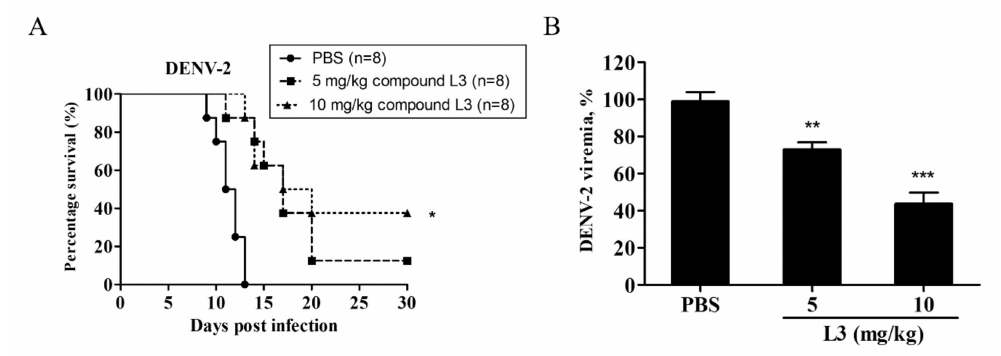
Figure 5. Compound L3 exhibited protective e ffi cacy in vivo. AG129 mice were infected with 10 7 focus-forming unit (FFU) of DENV-2 and treated orally with 5 or 10 mg / kg of compound L3 daily for 7 days. ( A ) Survival rates were determined for 30 days. The number of animals (n) in each group is shown. The data are representative results of three independent experiments. * p < 0.05. ( B ) Mouse sera were collected on day 3 after treatment. A focus-forming assay was used to measure DENV-2 viremia. Data are the mean ± SD of three independent experiments. ** p < 0.01, *** p < 0.001 according to a two-tailed Student’s t